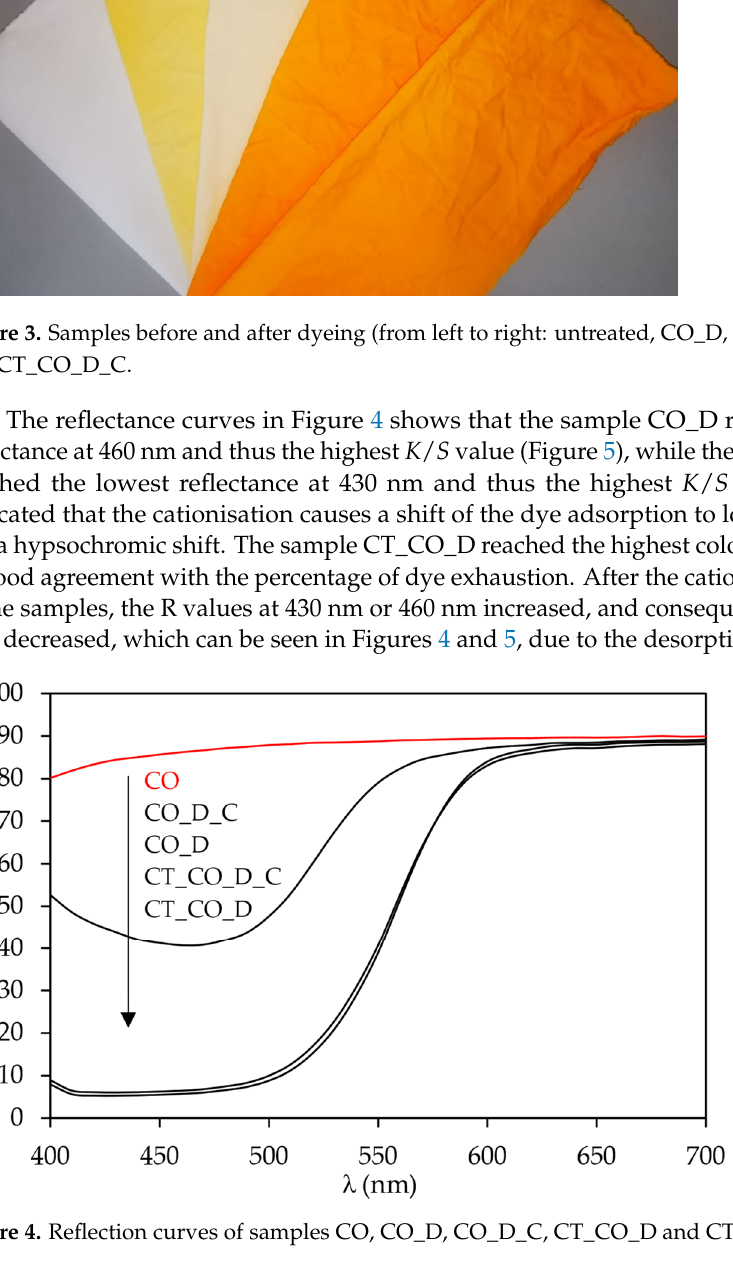
Figure 5. Values of K / S in dependence of the wavelength ( λ ) of samples CO, CO_D, CO_D_C, CT_CO_D and CT_CO_D_C. The pH responsiveness of coon fabric dyed in the presence of an electrolyte was not tested due to the very low adsorption of the MO dye to coon fabric. It was tested only on dyed samples cationised before dyeing with the immersion of test pieces into buffer solu- tions of different pH values. Figures 6 and 7 show that both samples CT_CO_D and CT_CO_D_C are pH-responsive since the bathochromic shift from 430 nm (sample before immersion) to 450 nm (sample after immersion) was noticed. The colour change was vis- ually detected by the naked eye when the sample was weed with buffer solution after it was immersed. Due to the very high hydrophilic character of coon fabric, the response time was shorter than three seconds, even though another five minutes waited for com- plete colour change at a specific pH value of the buffer.